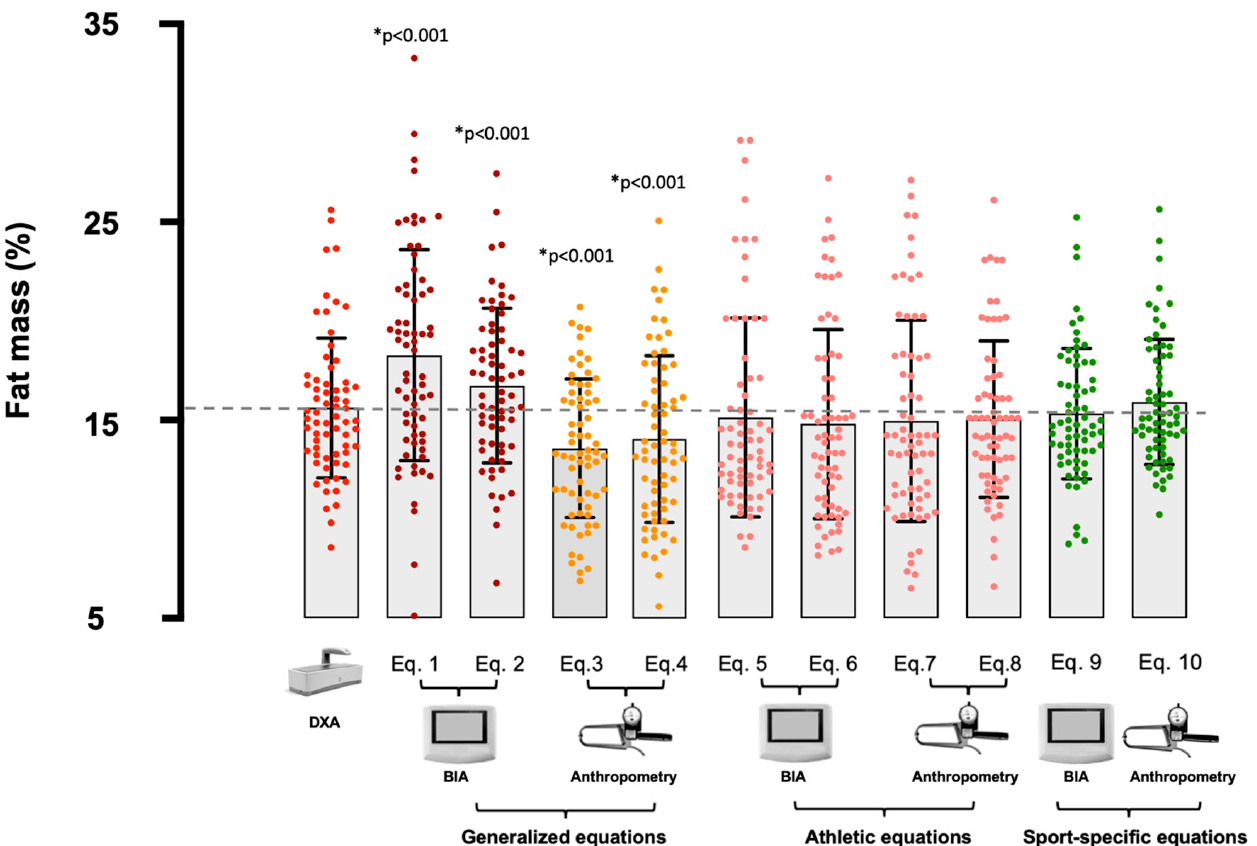
Figure 1. Mean and individual values for the percentage of fat mass (FM%) obtained from Dual X-ray Absorptiometry (DXA) and the selected equations; the upper and lower limits represent the standard deviation of the data. BIA = bioelectrical impedance analysis; Eq. 1 = Lukaski and Bolonchuk [21]; Eq. 2 = Sun et al. [22]; Eq. 3 = Durnin and Womersley [23]; Eq. 4 = Lean et al. [24]; Eq. 5 = Matias et al. [25]; Eq. 6 = Stewart et al. [26]; Eq. 7 = Evans et al. [27]; Eq. 8 = Witers et al. [28]; Eq. 9 = Matias et al. [29]; Eq. 10 = Giro et al. [30]. The dotted line identifies the mean value obtained with DXA; * = significant difference from DXA.